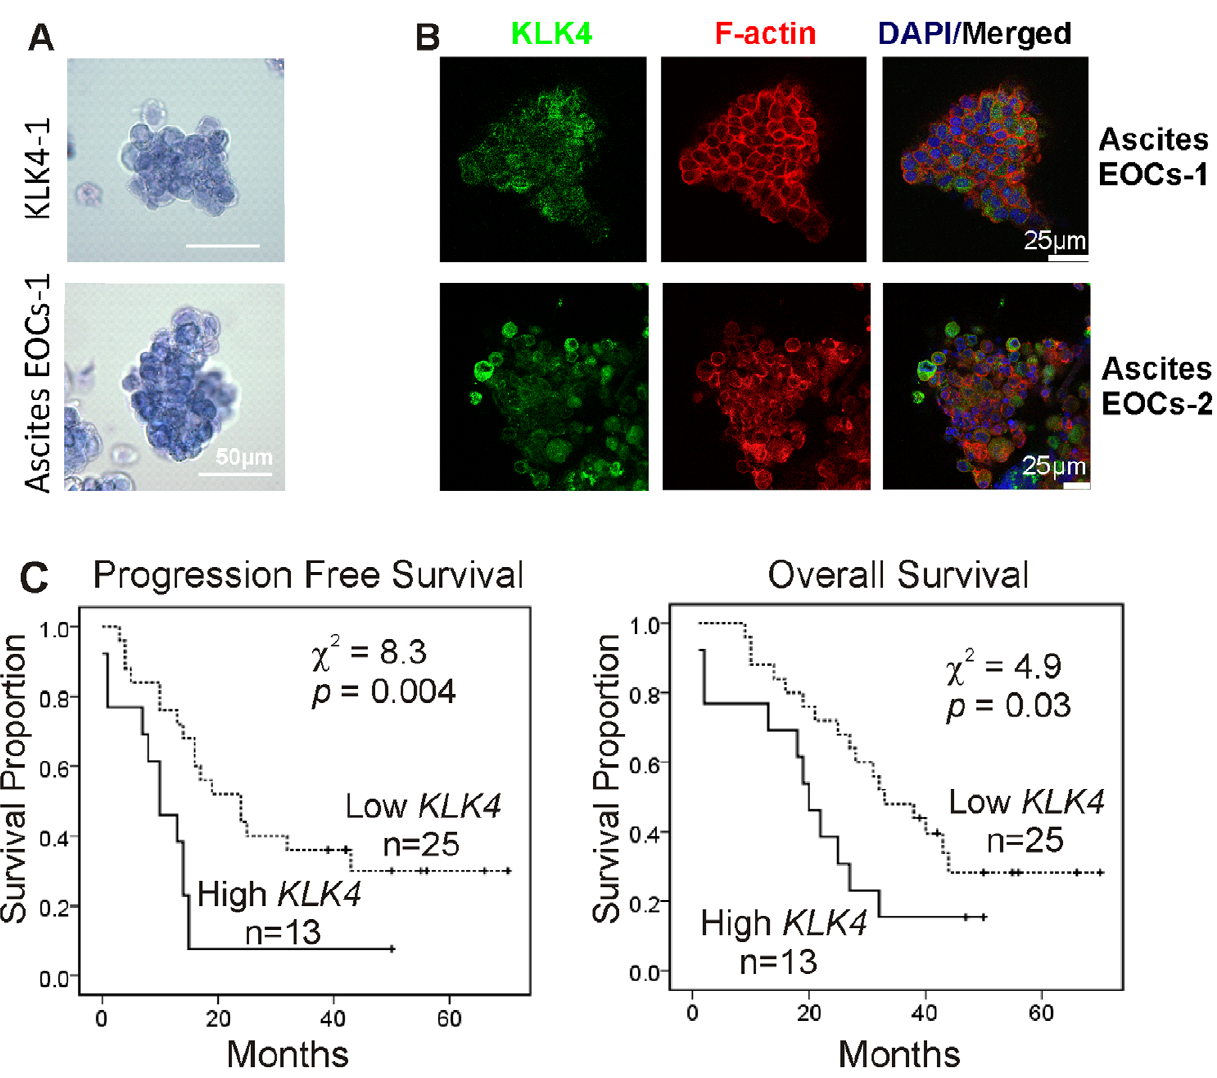
Figure 6. KLK4 is associated with poor outcome of patients. A. Phase contrast images show the similar morphology of trypan blue stained KLK4-1 MCAs and ascites-derived MCAs from a serous EOC patient. Scale bar, 50 m m. B. IF confocal microscopy with an antibody against KLK4 (green), phalloidin (red) and DAPI (blue) in ascitic serous EOC MCAs from 2 patients; scale bars, 25 m m. C. Kaplan-Meier survival analysis shows the relationship between KLK4 mRNA levels in tumor tissue samples and survival status of a cohort of 38 serous EOC patients. Left panel, progression free survival (PFS) time for patients with low KLK4 (n=25) and high KLK4 (n=13) levels ( x 2 =8.3, p =0.004). Right panel, overall survival time for patients with low KLK4 (n=25) and high KLK4 (n=13) levels ( x 2 =4.9, p